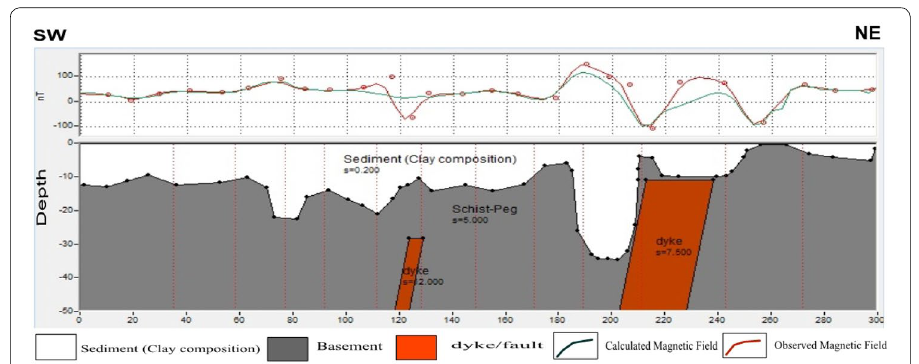
Fig. 15 Model of magnetic profile along traverse 2